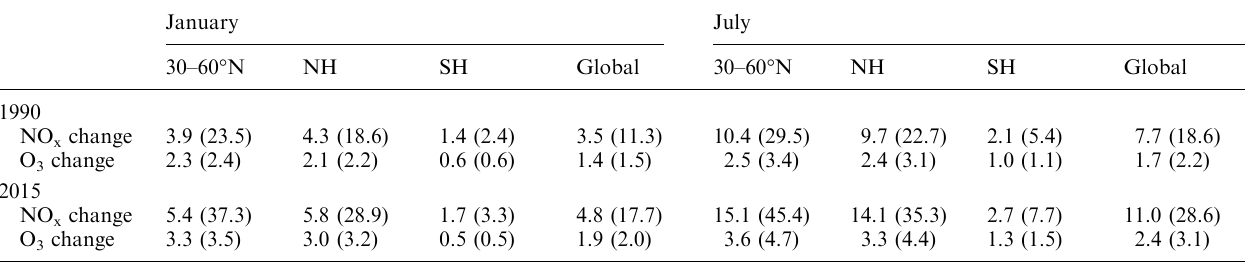
Fig. 4. Ozone perturbation for January and July due to aircraft emissions for the reference year 1990. Top figures show the zonally-averaged O perturbation (ppbv). The lower figures show the distribution of the O Table 2. Changes in the NO and O burden (%) from the ground x 3 to 150 hPa and from 450 to 150 hPa (in parentheses) caused by aircraft NO emissions. The average values for 30–60 (cid:176) N, for the x